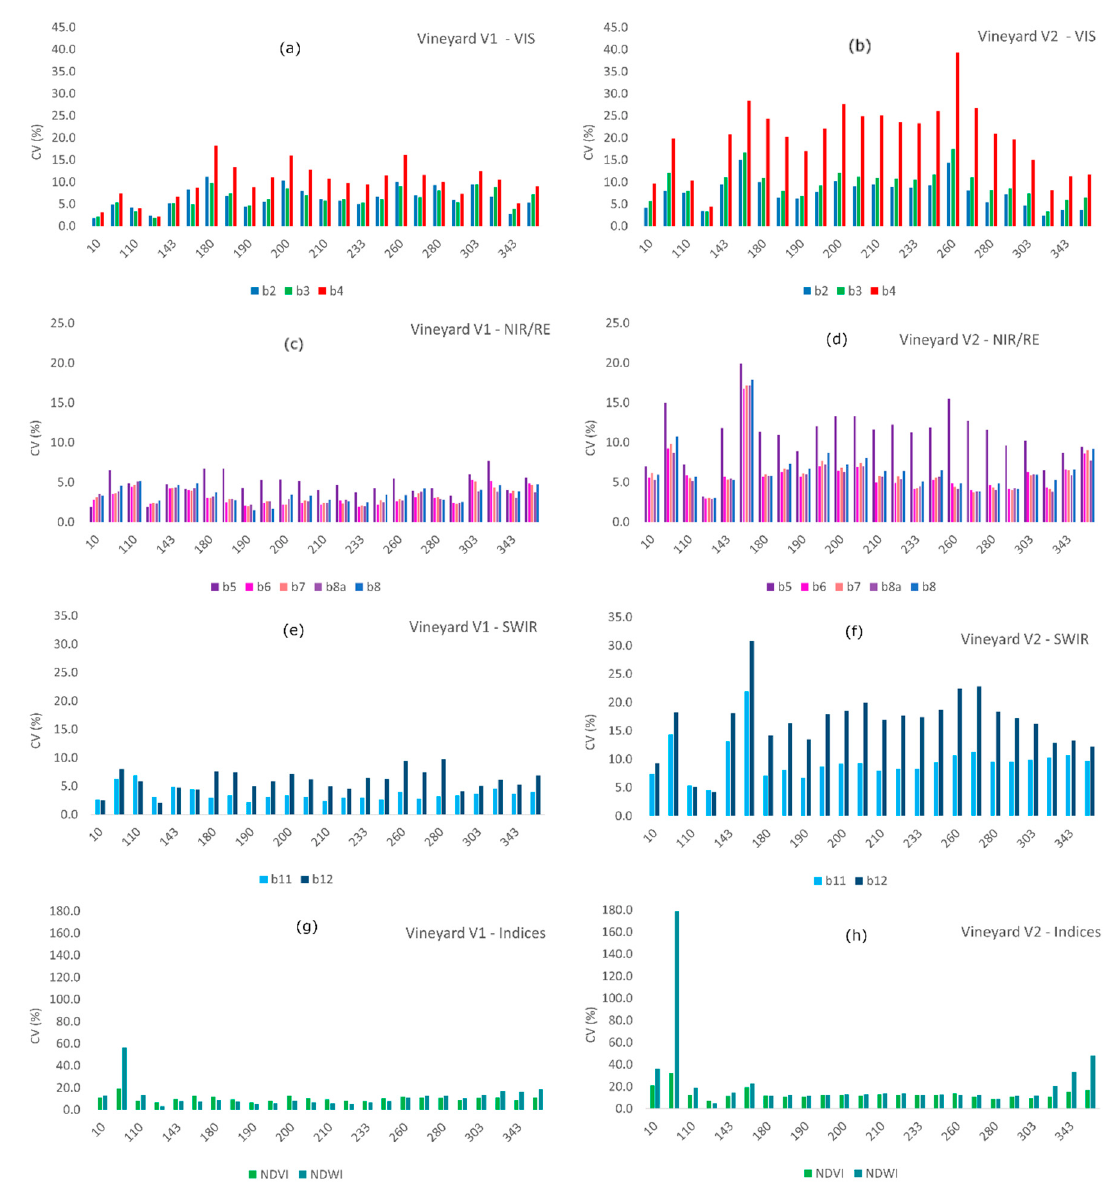
Figure 8. Coefficients of variation (CV) of uncovered vineyards (V1 and V2) along the year (2016). CV concerns spatial distribution of band/index values within the vineyard. Values were computed at plot level for each date for all the considered S2 bands and for NDVI and NDWI indices. Figures ( a ), ( c ), ( e ) refer to vineyard V1 and show temporal trends of visible, NIR and SWIR bands, respectively. Similarly, figures ( b ), ( d ), (f) refer to vineyard V2 and show temporal trends of visible, NIR and SWIR bands, respectively. Figure ( g ) and (h) show temporal trends of spectral indices (NDVI, NDWI) for vineyard V1 and V2 respectively.